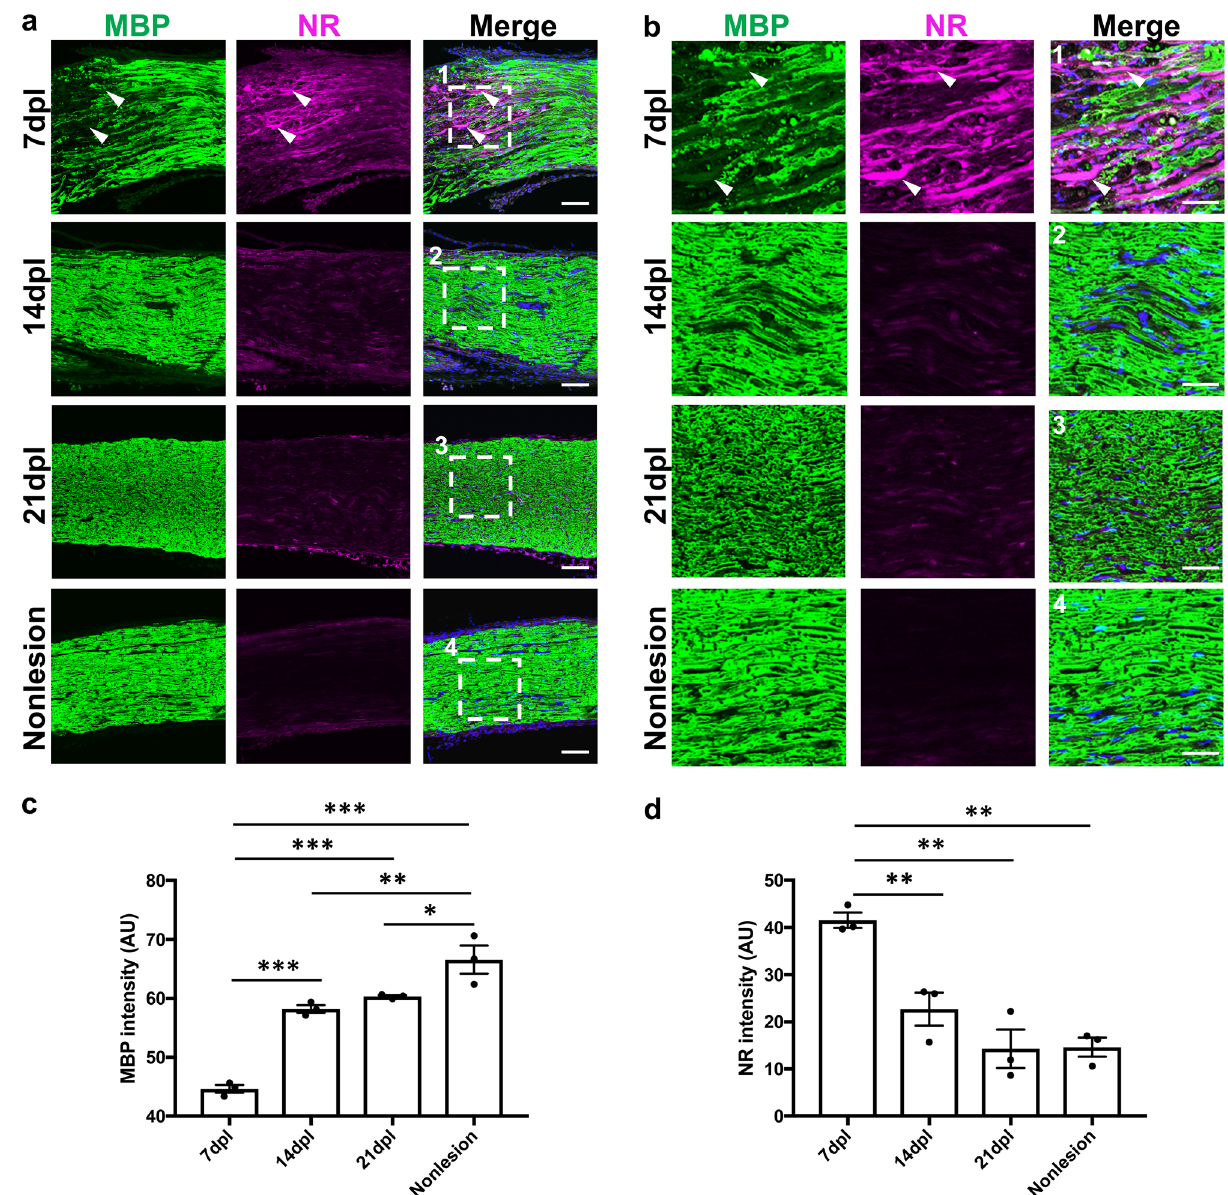
lysophosphatidylcholine injection at 7, 14, 21 dpl and a nonlesion area at 7 dpl (n = 3 mice per timepoint examined). ( b1–4 ) Enlarged images of ( a1–4 ) (white dotted square). The demyelinated lesion with weak MBP immunoreactivity is shown in 7 dpl image ( a , b ; arrowhead). Quantification of fluorescence intensity based on MBP staining ( c ) and NR ( d ) labeling in lesion at 7, 14, and 21 dpl and a nonlesion area at 7 dpl (n = 3). Nuclei were counterstained with Hoechst (blue). Scale bar, 50 µm ( a ) and 20 µm ( b ). Mean ± s.e.m. One-way ANOVA, Tukey–Kramer test. *P < 0.05, **P < 0.01, ***P < 0.001. Graphs were created using Prism 7 (GraphPad Software), https:// www. graph pad.